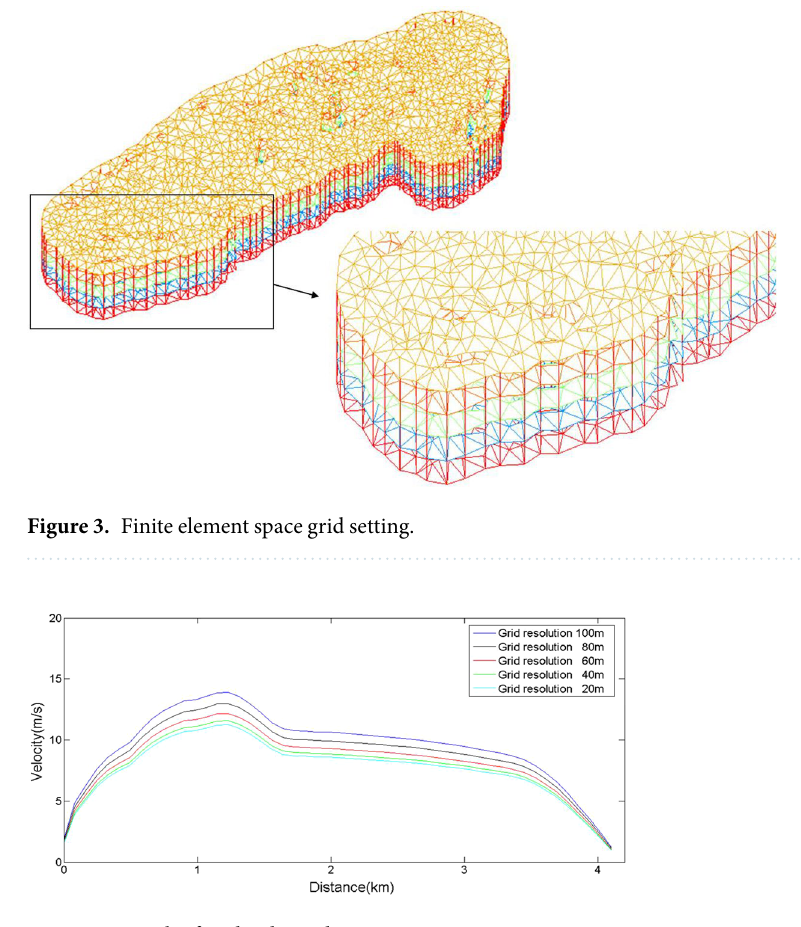
Figure 4. Result of grid independence test.